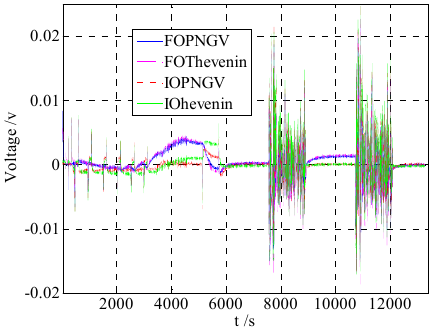
Figure 8. Terminal voltage estimation error under hybrid cycle.